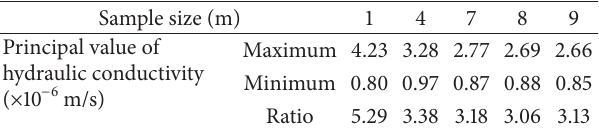
Table 2: Principal values 𝐾 [15] of fracture hydraulic conductivity at different sizes.